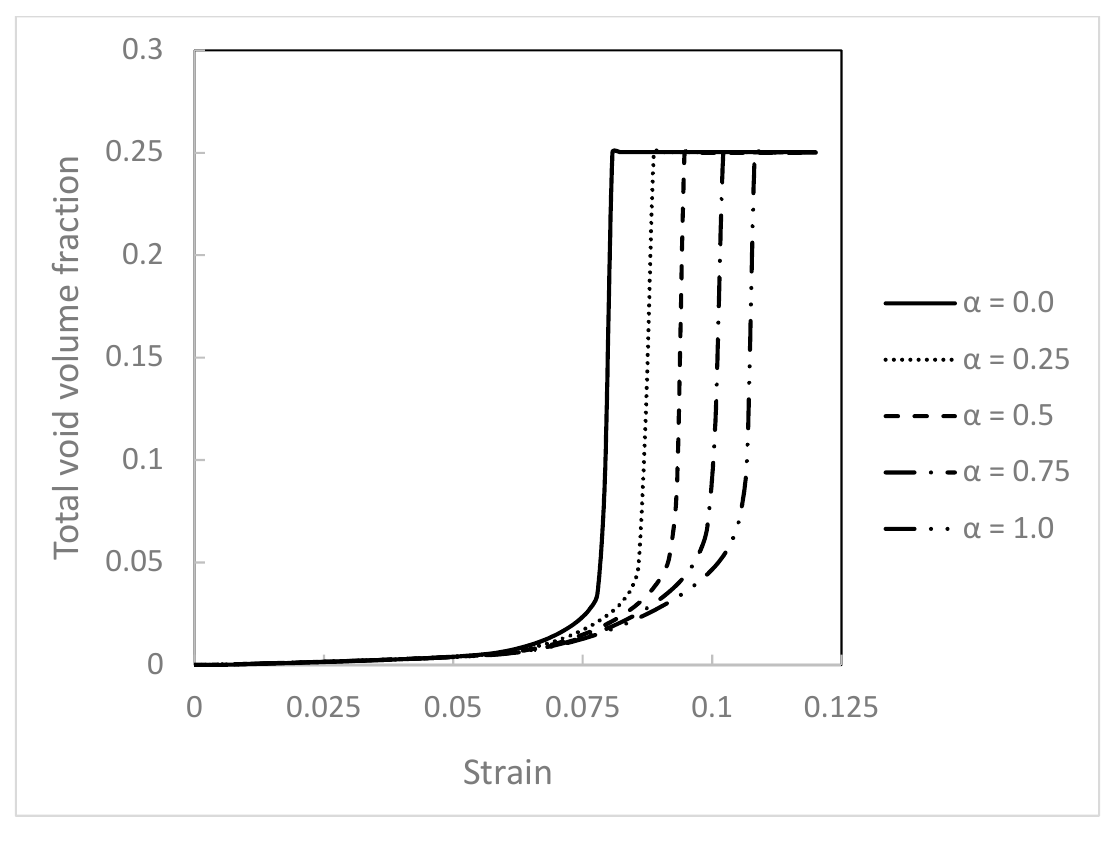
Figure 10. Effect of superimposed hydrostatic pressure on ( a ) void nucleation volume fraction, ( b ) void growth volume fraction, ( c ) shear void growth volume fraction and ( d ) total void volume fraction at the center of the specimen.